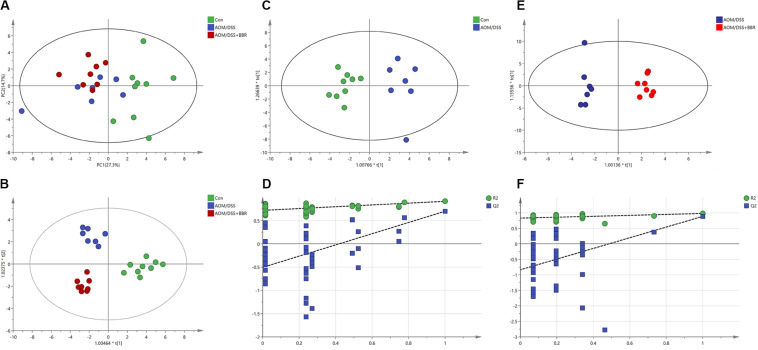
Metabolic analysis. (A,B) The PCA scatter plot and OPLS-DA score plots of the 1H NMR data of feces samples among control, AOM/DSS, and AOM/DSS + BBR group. (C,D) The OPLS-DA score plots and validation plot based on the 1H NMR data of feces samples obtained from control and AOM/DSS group. (E,F) The OPLS-DA score plots and validation plot based on the 1H NMR data of feces samples obtained from AOM/DSS and AOM/DSS + BBR group.